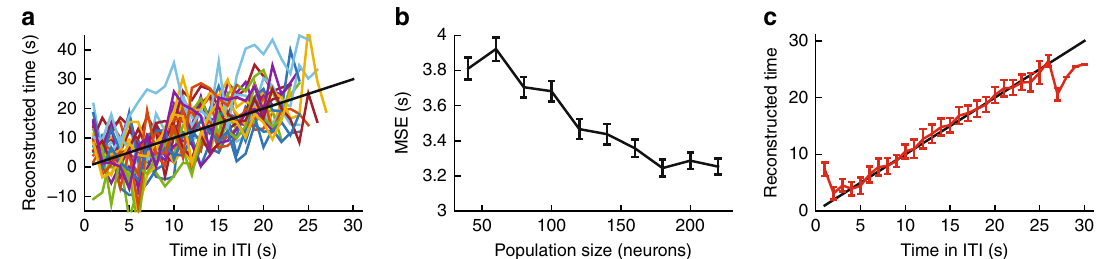
Fig. 8 Time in ITI obtained from neural activity. a Decoding the time in the ITI from neural activity. Shown are 25 individual repetitions, when calculating each neuron preferred time on a set of 25 trials (drawn pseudorandomly for each repetition), and using it to estimate time from the actual fi ring rate in the remaining 5 trials. Black line marks identity line (perfect prediction). b The estimation error as a function of number of neurons used (neurons were taken as independent and collected from all days). The error drops, but seems to plateau around 3 s resolution. c Average of 100 repetitions using all available neurons. The population estimates the time in the ITI with small bias (edges are biased due to fl oor/ceiling effects). Black line marks identity line (perfect prediction). Data presented as mean ± S.E.M.